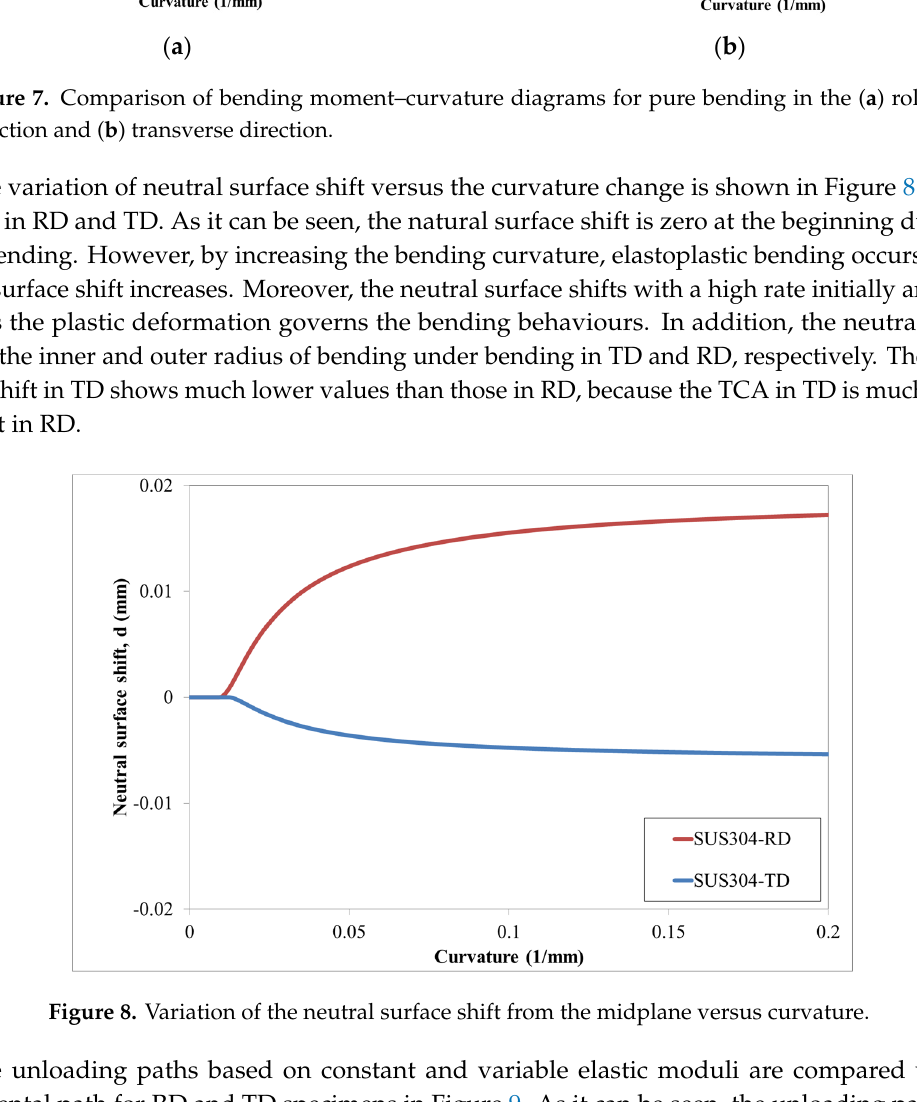
( b ) Figure 9. Comparison of the analytical and experimental bending moment–curvature diagram and nonlinear unloading in the ( a ) rolling direction and ( b ) transverse direction. 3.3. Numerical Study of Pure Bending of DP980 and SUS304 The analytical solution based on Cazacu–Barlat 2004 and the Voce hardening rule was implemented in the UMAT subroutine in ABAQUS/Standard. The radial return algorithm [26], which applies an implicit integration technique, was applied and improved to solve the constitutive equations. In the first step, the pure bending tests were simulated, and the results were compared with the analytical results. For pure bending tests, a 2D strip with the same dimensions used in experimental tests was modelled. Due to the symmetric boundary condition about the plane along the centreline of the sheet, only half of the sheet sample was modelled along with the rigid body to model the clamp as a fixture to the sample, as shown in Figure 10. The clamp was modelled as a discrete rigid part and fused to the right edge of the strip using the tie constraint. The moment was applied at point A, which is the reference point of the clamp. Thirty elements through the thickness